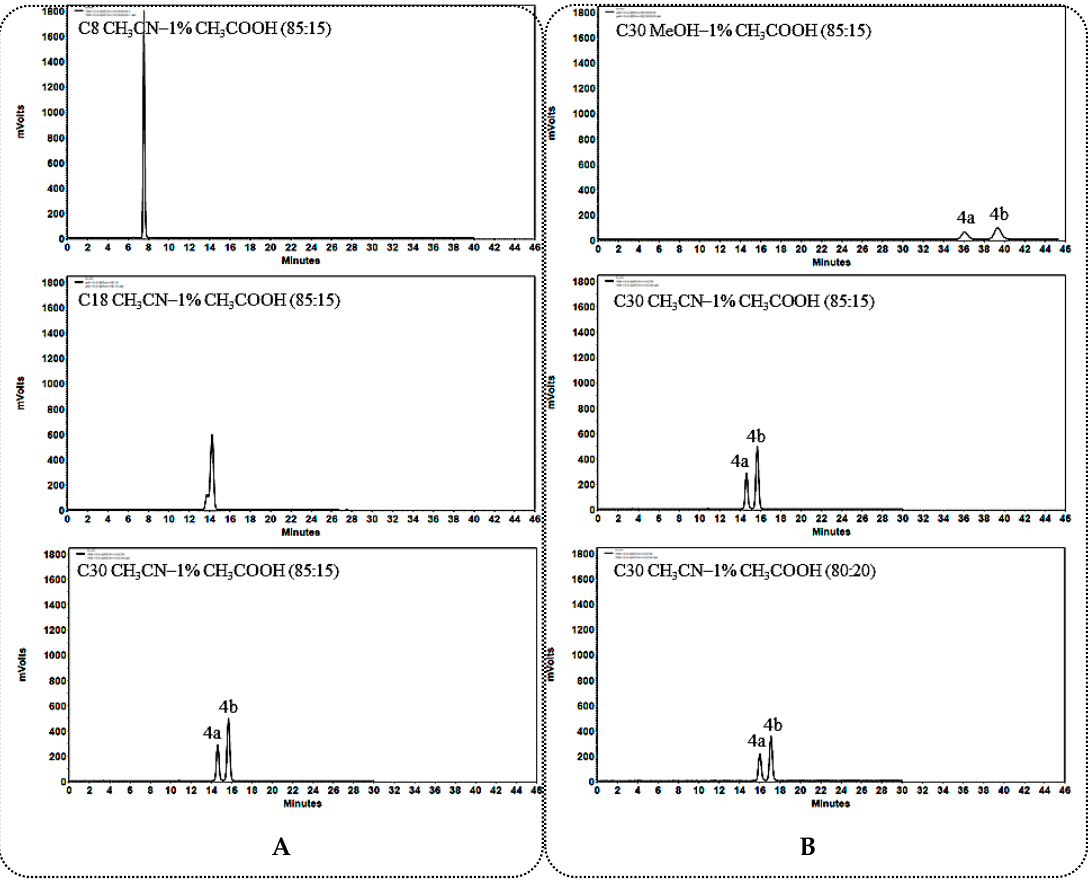
Figure 5. ( A ) Chromatograms of 4a and 4b separated on C 8 , C 18 , C 30 column; ( B ) Chromatograms of 4a and 4b separated on the C 30 column in different solvent systems.